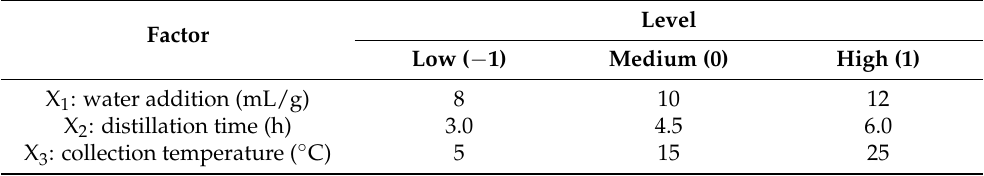
Table 3. The factors and levels of the Box–Behnken design.